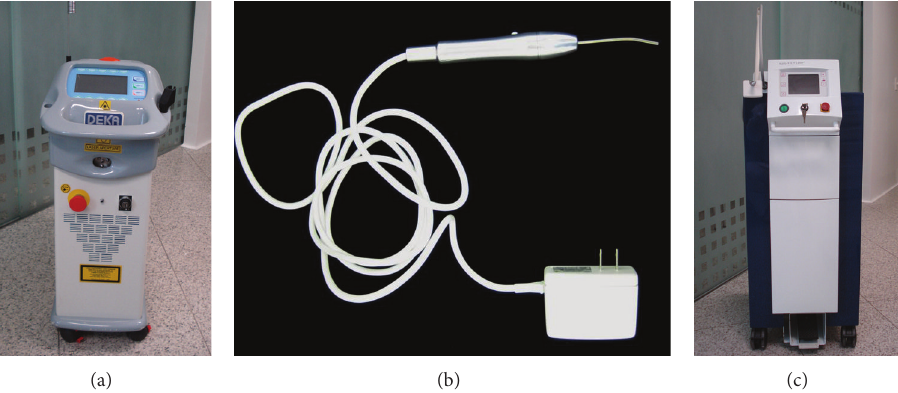
Figure 2: (a) Nd:YAG laser (1,064nm): microbial reduction; low power laser (660 nm): soft tissue biomodulation; Er:YAG laser (2,940 nm): conditioning of the inner ceramic